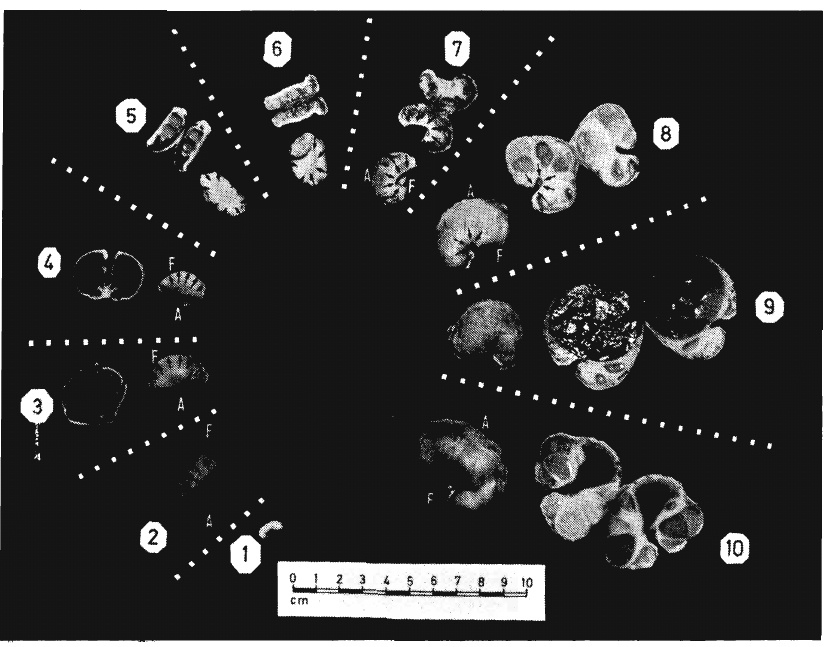
Fig. 4. Growth and development of the Burchell's zebra ovary from the pre natal through the early postnatal to the adult stage. Development proceeds in a clockwise direction from (1) to (10). With the exception of(1) and (2) all ovaries are arranged in pairs (each pair being from the same animal) those in the outer circle having been sliced down the centre from the free to the attached border and then opened out. With the exception of (5) and (6) the ovaries of the inner circle are arranged with their attached (mesovarial) borders in the same direction e.g. the edge of (2) closest to the "scale" is the attached border while the edge of (10) furthest from the "scale" is the attached border. In the case of (5) and (6) the free borders are dorsally situated. The small arrows present on ovaries (2) of the inner circle illustrate development of the ovarian